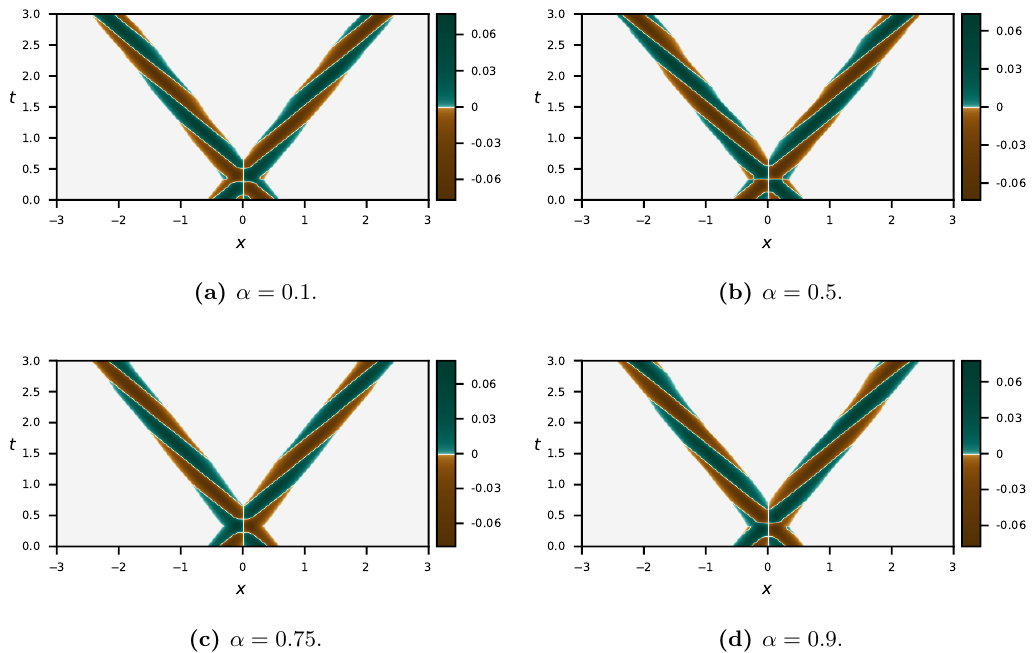
Figure 14 . The scattering of oscillons (antisymmetric con(cid:12)guration) as a function of their phase (cid:11) . The initial con(cid:12)guration contains oscillons with speed V = 0 : 8 and no zig-zag motion of their border.